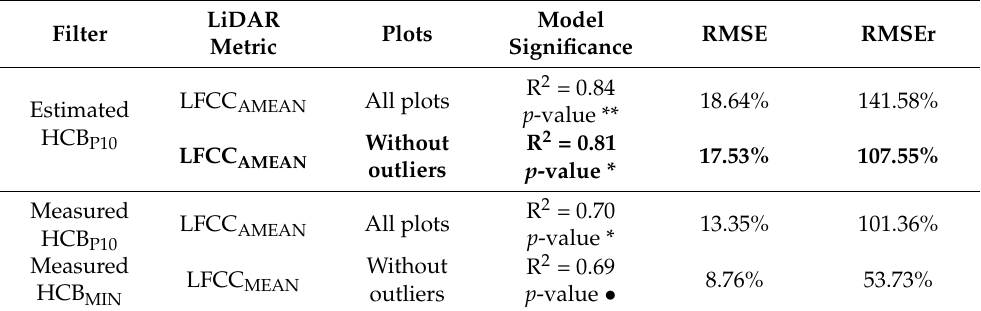
Table 4. Understorey cover: summary error statistics produced by assessing field measurements and LiDAR